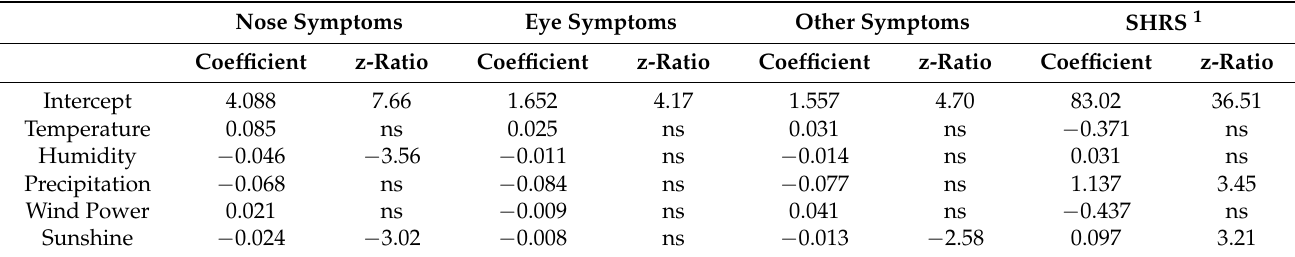
Table 3. Relation between seasonal allergic rhinitis symptoms, self-rated health status (SRHS) and different environmental (weather) parameters. Nose Symptoms Eye Symptoms Other Symptoms SHRS 1 z-Ratio